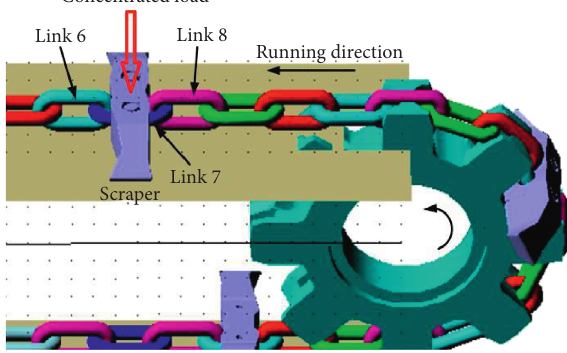
Figure 6: Impact load operating mode